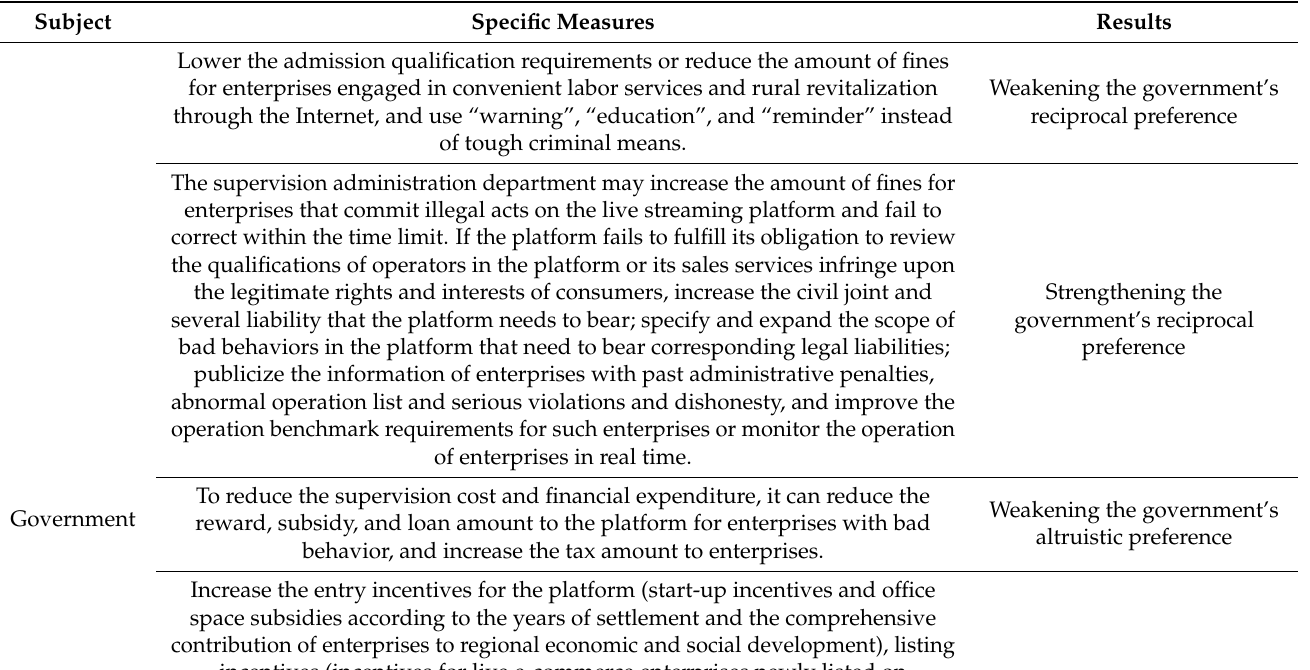
Table 6. The government-platform governance measures in the promotion